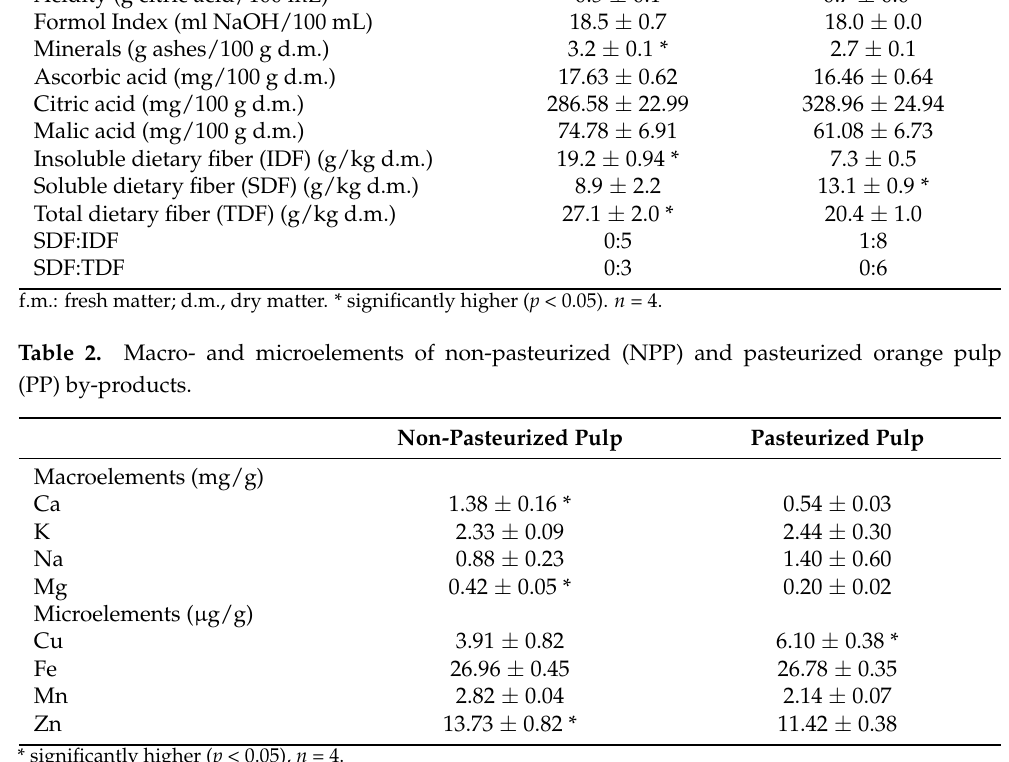
Table 1. Characterization of non-pasteurized (NPP) and pasteurized (PP) orange pulp by-product. Non-Pasteurized Pulp Pasteurized Pulp Moisture (g water/100 g f.m.)